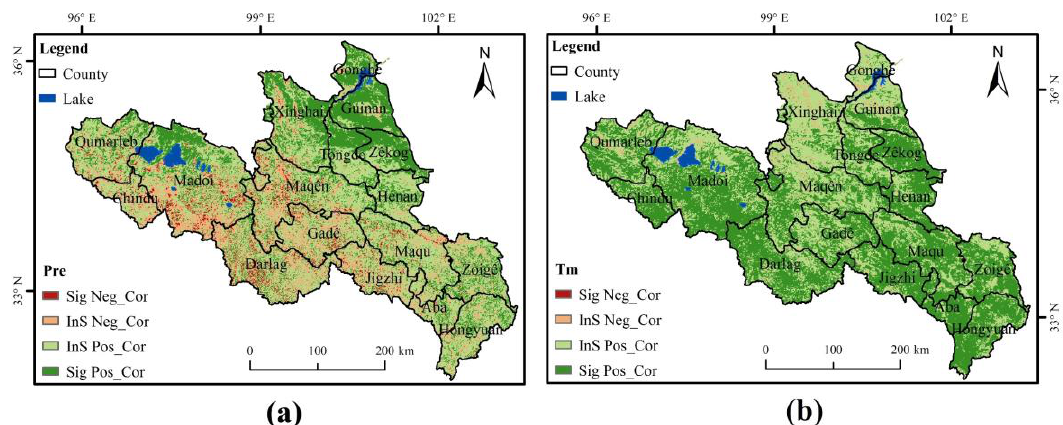
Figure 6. Spatial distribution of the correlation analysis for the NDVI and climate elements: ( a ) precipitation; ( b ) temperature. In the figure, Sig Neg_Cor represents a significant negative correlation; InS Neg_Cor represents a nonsignificant negative correlation; InS Pos_Cor represents a nonsignificant positive correlation; and Sig Pos_Cor represents a significant positive correlation.